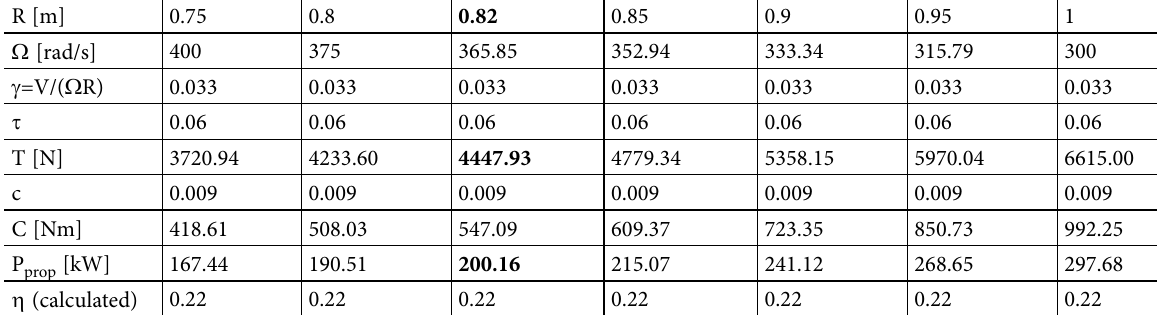
Table 1. Parametric study of propeller performance vs radius R with β = 15°